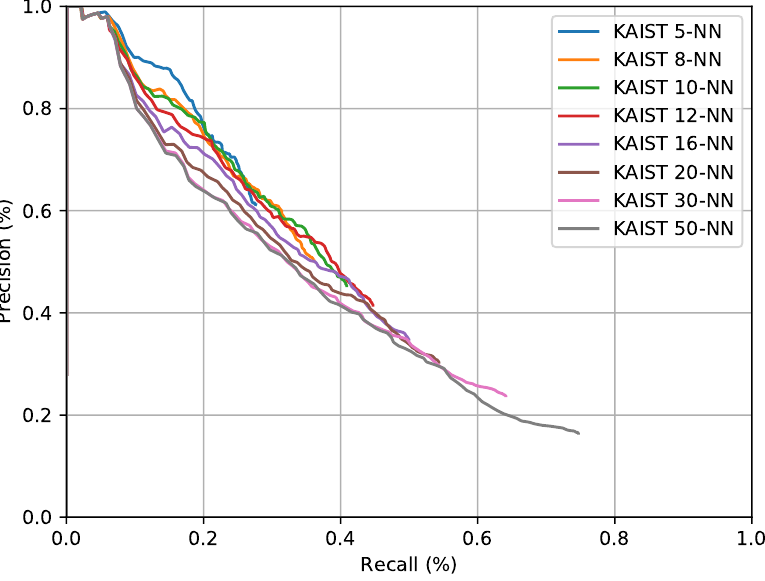
Figure 13. A family of pr curves for the method of Reference [11] as run on the dataset collected in central